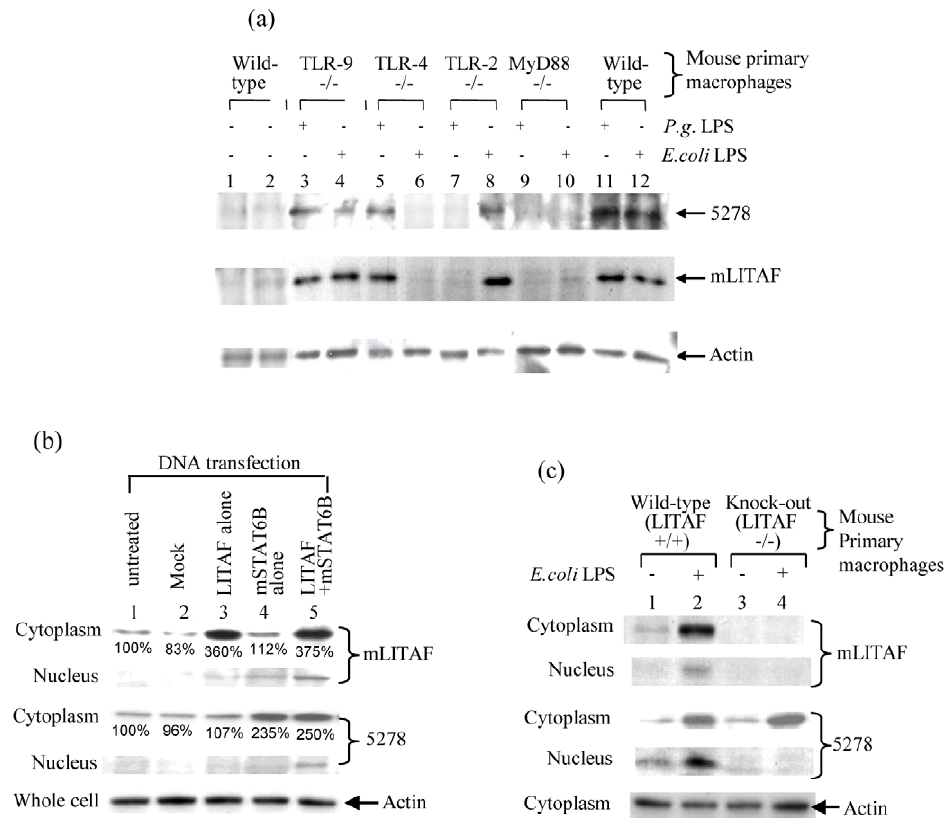
Figure 1. mSTAT6B/mLITAF signaling pathway. (a) The primary macrophages collected from various deficient genotype mice (No. 1&2 and 11&12 for wild-type as the control, No. 3&4 for TLR-9 2 / 2 , No. 5&6 for TLR-4 2 / 2 , No. 7&8 for TLR-2 2 / 2 , or No. 9&10 for MyD88 2 / 2 ) were treated with 0.1 m g/ml P. gingivalis LPS (No. 3,5,7,9&11) or 0.1 m g/ml E. coli LPS (No. 4,6,8,10&12) for 2 hrs and washed with PBS and cultured overnight. The cell lysate from each test group was subjected to Western blot with antibodies against mSTAT6B (5278), mLITAF or Actin as the control. The assays